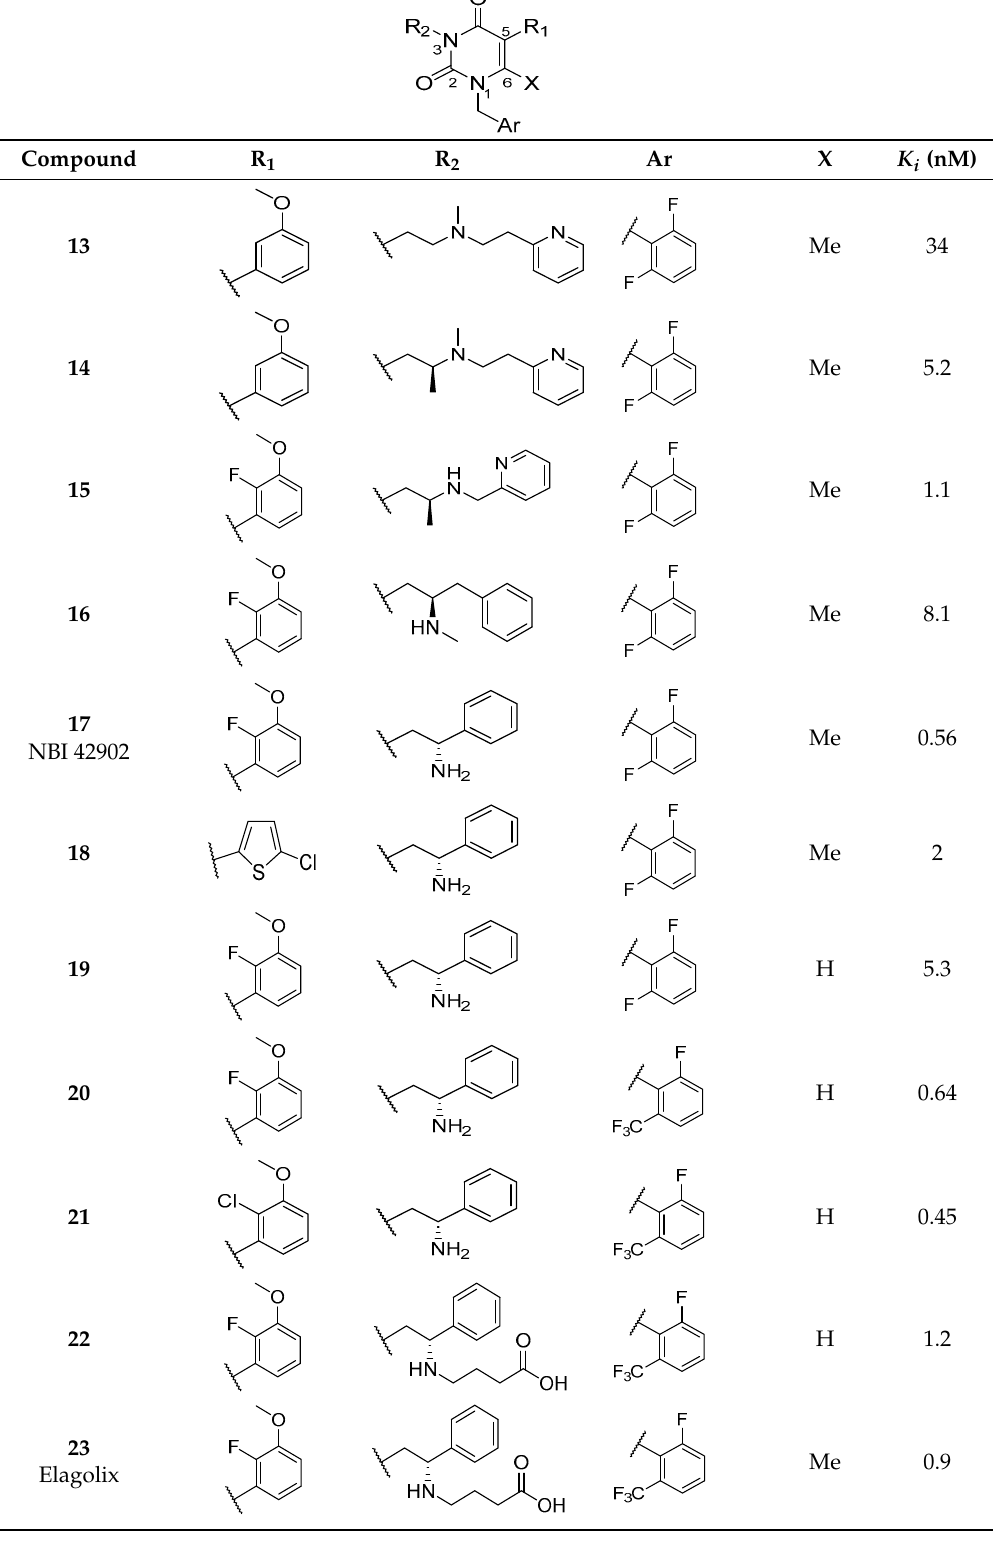
Table 5. Uracil derivatives and their binding affinity at human GnRH-R.